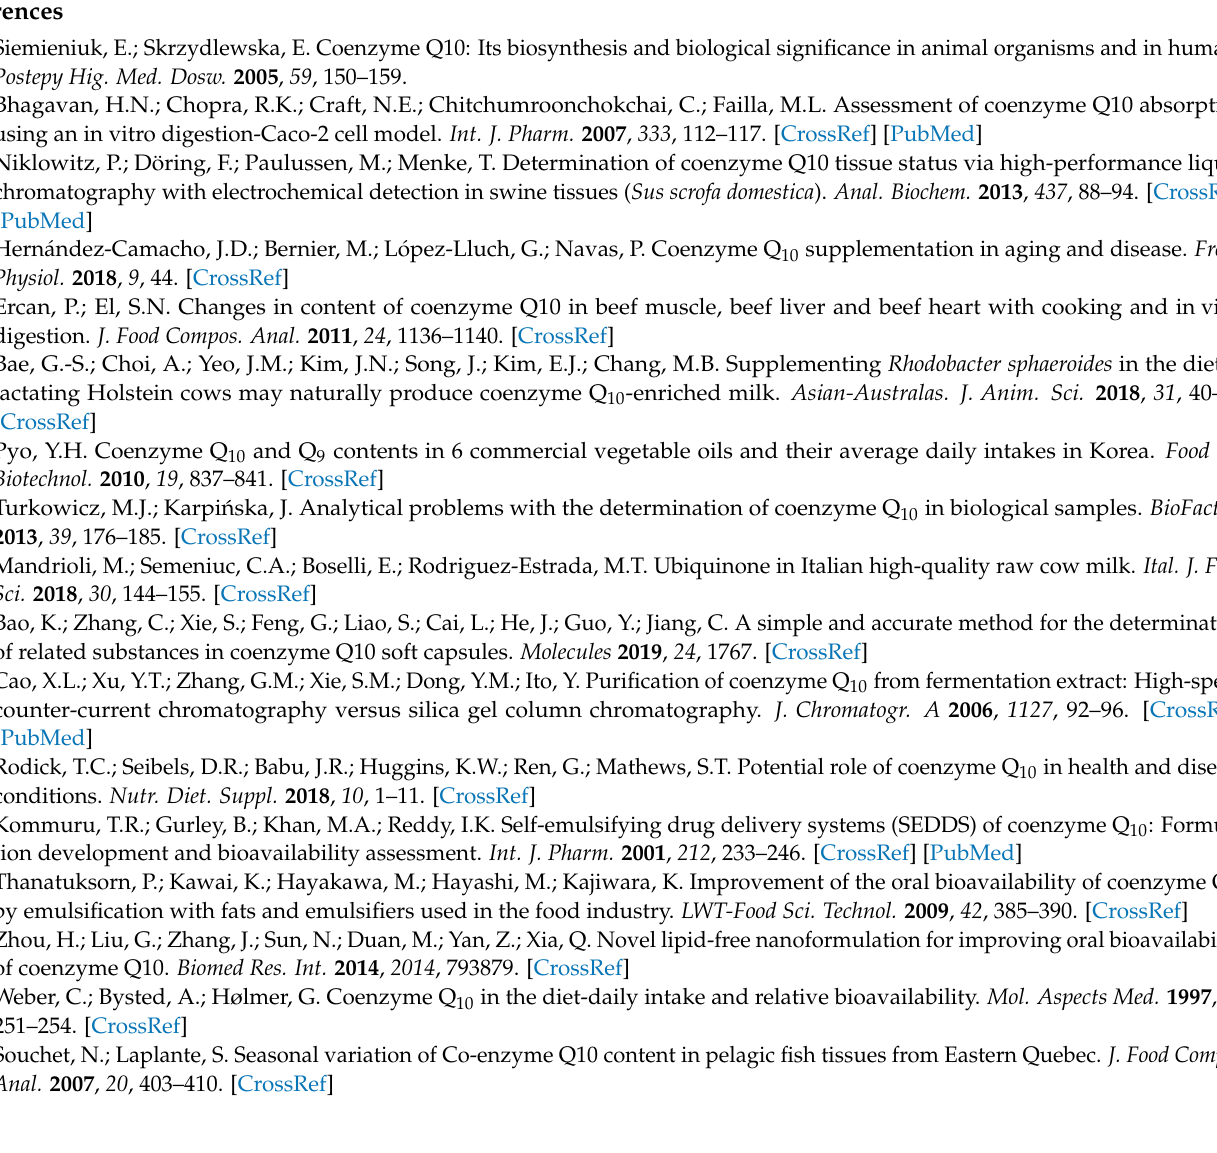
Rodr í guez-Acuña et al., 2008; Figure S12: Workflow of the analytical method adapted from Tobin et al., 2014; Figure S13: Workflow of the analytical method adapted from Niklowitz et al., 2013; Figure S14: Workflow of the analytical method adapted from Mattila et al., 2000; Figure S15: Workflow of the analytical method adapted from Purchas et al., 2004; Figure S16: Workflow of the analytical method adapted from Souchet and Laplante, 2007; Figure S17: Workflow of the analytical method adapted from Mandrioli et al., 2018; Figure S18: Workflow of the analytical method adapted from Manzi and Durazzo, 2015; Figure S19: Workflow of the analytical method adapted from Xue et al.,